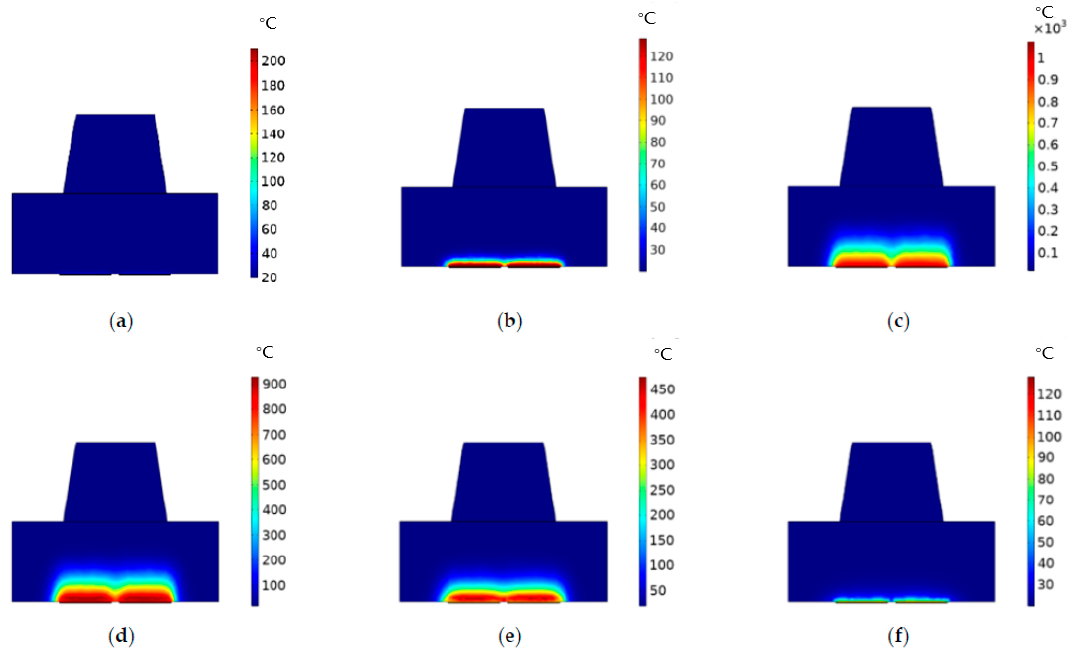
Figure 8. The temperature distribution of fluid in the chamber under a driving voltage of 12V: ( a ) temperature distribution of the fluid in the chamber at 0.1 µ s; ( b ) temperature distribution of the fluid in the chamber at 1.2 µ s; ( c ) temperature distribution of the fluid in the chamber at 1.8 µ s; ( d ) temperature distribution of the fluid in the chamber at 2.5 µ s; ( e ) temperature distribution of the fluid in the chamber at 4.5 µ s; ( f ) temperature distribution of the fluid in the chamber at 9 µ s. In order to research the change in temperature in the chamber more directly, we chose a red three-dimensional straight line as the object. In the upper-right corner of Fig- ure 9, the line is located in the middle of the chopsticks-shaped heating resistors, perpen- dicular to the bottom of the chamber, at a height of 15 μ m. The x-axis corresponds to the